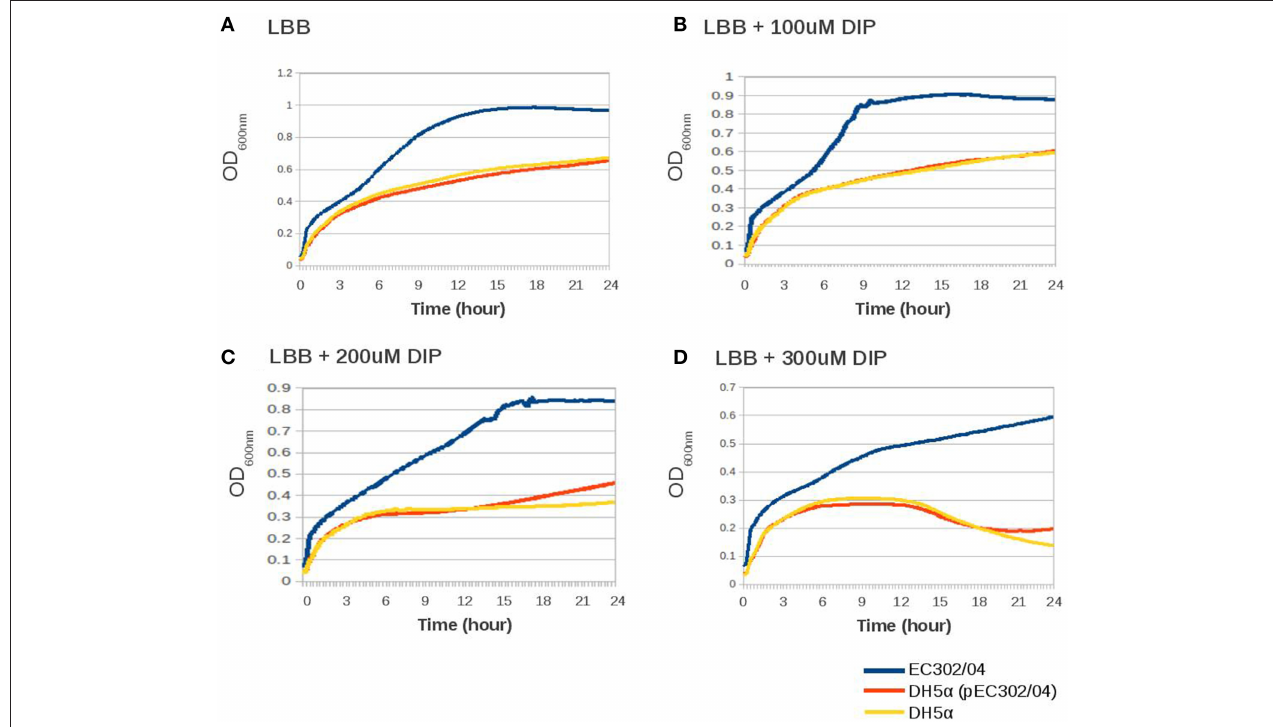
FIGURE 3 | Growth curves of EC302/04, E. coli DH5 α and DH5 α (pEC302/04) transconjugant in rich and iron-limited medium. (A) LB broth; (B) LB broth supplemented with 100 µ M of DIP; (C) LB broth supplemented with 200 µ M of DIP; (D) LB broth supplemented with 300 µ M of DIP.